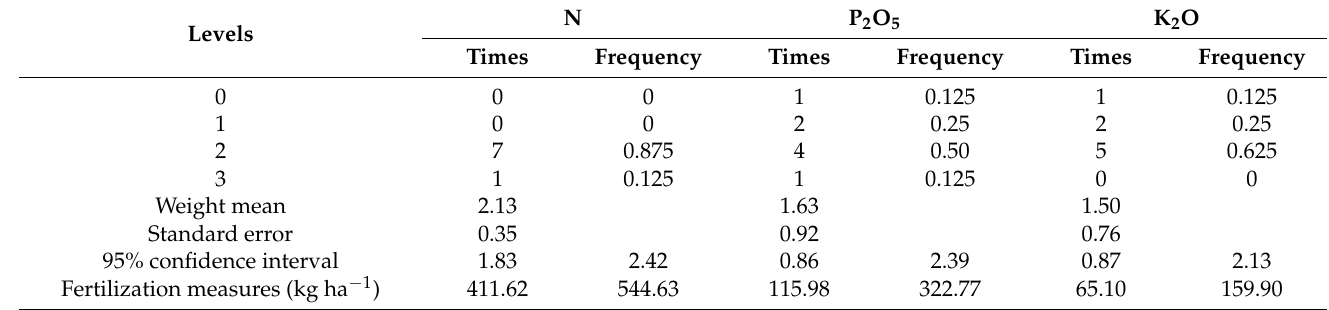
Table 6. The frequency distribution and fertilization measures for grain yield greater than 4480 kg ha − 1 . N P 2 O 5 Levels